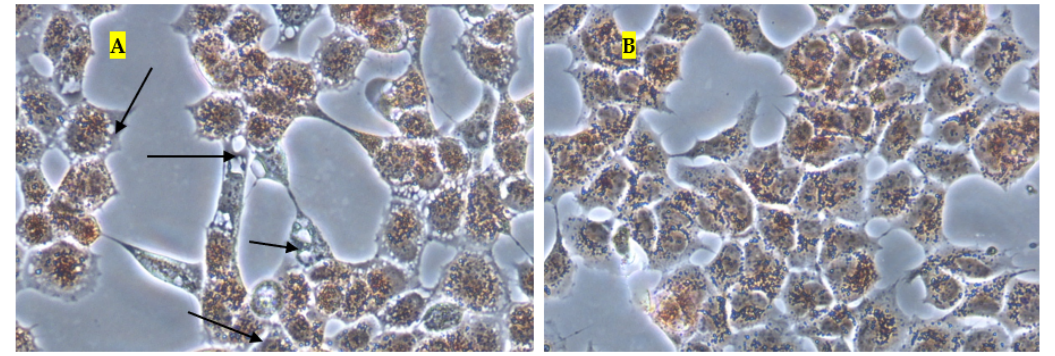
Figure 8. Micrographs of HEK293 ( A ) cells treated with Thymol-P407 250 mg/L ( B ) untreated cells (control) and stained with neutral red uptake assay (×200) (arrows showing vacuolization). Using the Sulforhodamine B assay, in Figure 9, the effect of thymol at 250 mg/L on the cells was observed. The thymol-P407 retained 85% of the cellular density compared to less than 3% with the thymol-HPMC, the P407 protected the cells from the effect of thymol. This result agreed with the NR assay results.